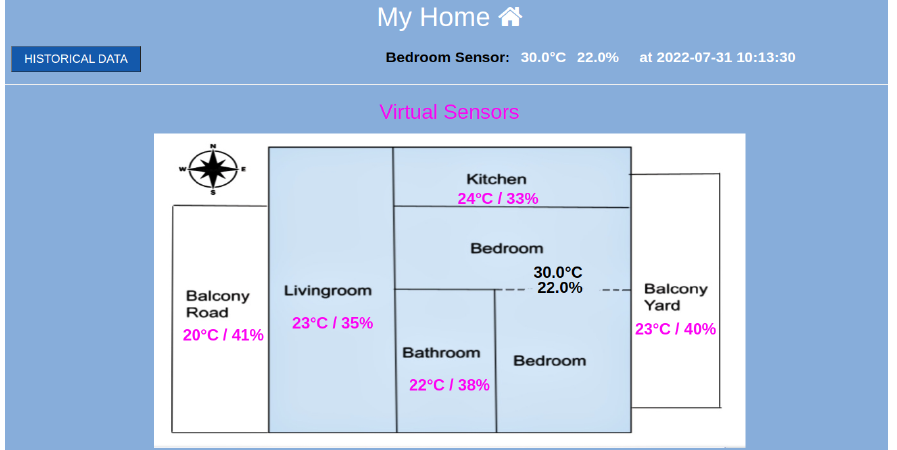
Figure 3. Physical and virtual temperature and humidity in a smart home.